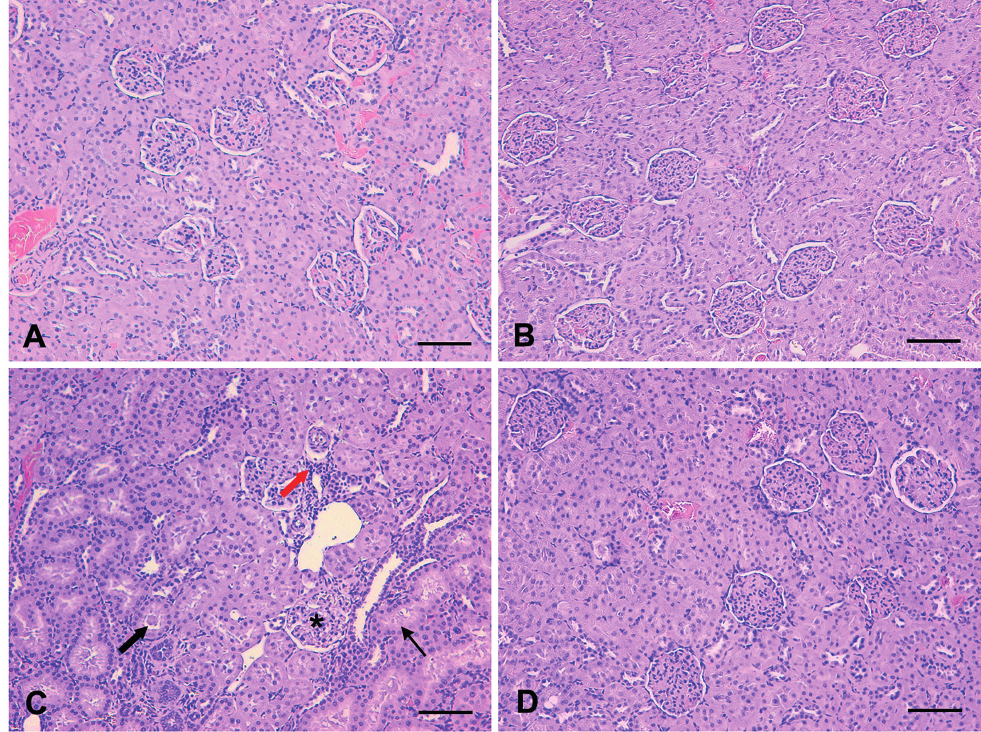
Figure 1 - Photomicrographs of the renal cortex from the experimental